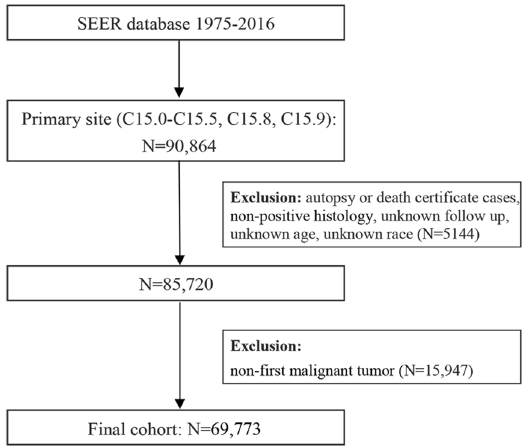
Figure 1. The flow diagram of patient selection (Description: There are steps of how to identify 161 suicidal patients from 90,864 esophageal cancer patients in Surveillance, Epidemiology, and End Results program